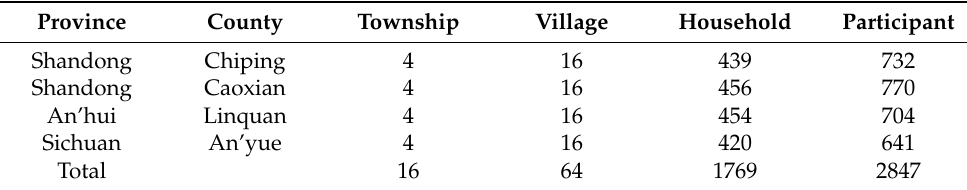
Table A1. Study areas and participants.